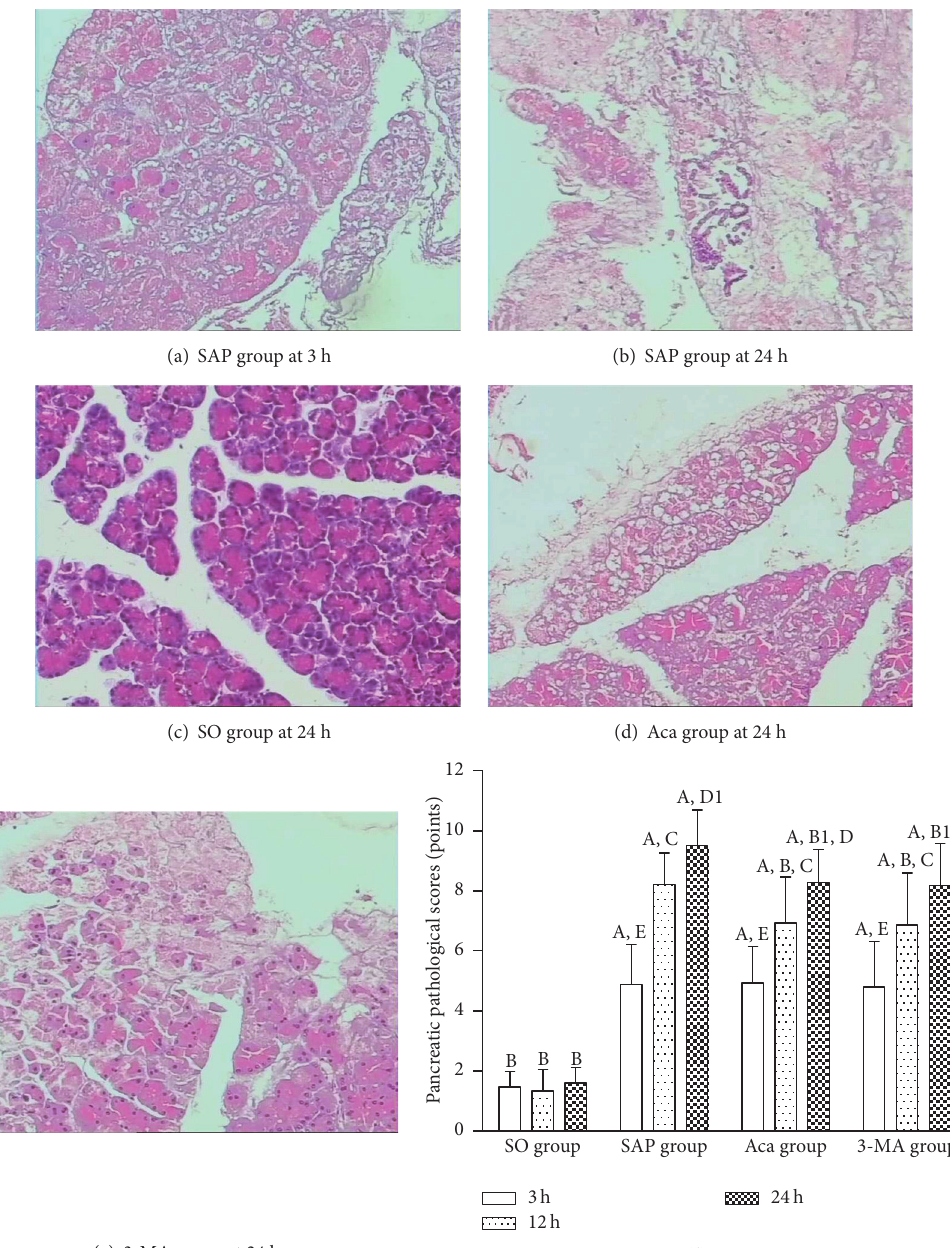
Figure 1: Pathological changes of the pancreas by light microscopy and pathological scores of pancreatic tissues. (a) SAP group at 3 h; (b) SAP group at 24 h; (c) SO group at 24 h; (d) Aca group at 24h; (e) 3-MA group at 24 h (HE, × 200). (f) Comparison of pancreas pathological scores; A 𝑃 < 0.01 versus SO group at the same time point; B 𝑃 < 0.01 ; B 1 𝑃 < 0.05 versus SAP group at the same time point; 12 h versus 3 h in the same group, C 𝑃 < 0.01 ; 24 h versus 12h in the same group, D 𝑃 < 0.01 ; D 1 𝑃 < 0.05 ; 24 h versus 3 h in the same group, E 𝑃 < 0.01 . SO: